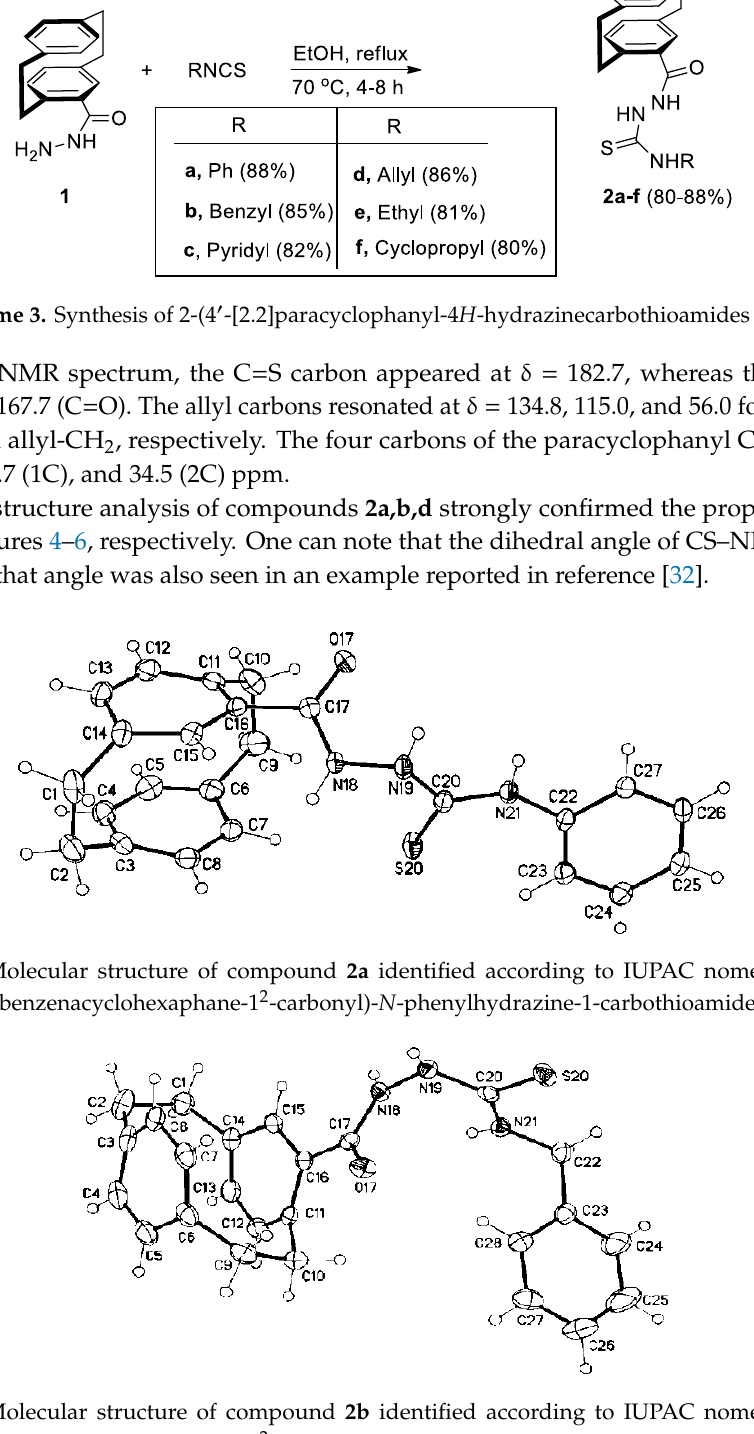
Figure 6. Molecular structure of compound 2d identified according to IUPAC nomenclature as 2- (1,4(1,4)-dibenzenacyclohexaphane-1 2 -carbonyl)- N -vinylhydrazine-1-carbothioamide. Refluxing 2a – f with dimethyl acetylenedicarboxylate ( 9 ) in EtOH afforded the expected thiazolidinones 3a,b,d – f in 67%–78% yield together with 3c in 65% yield (Scheme 4).